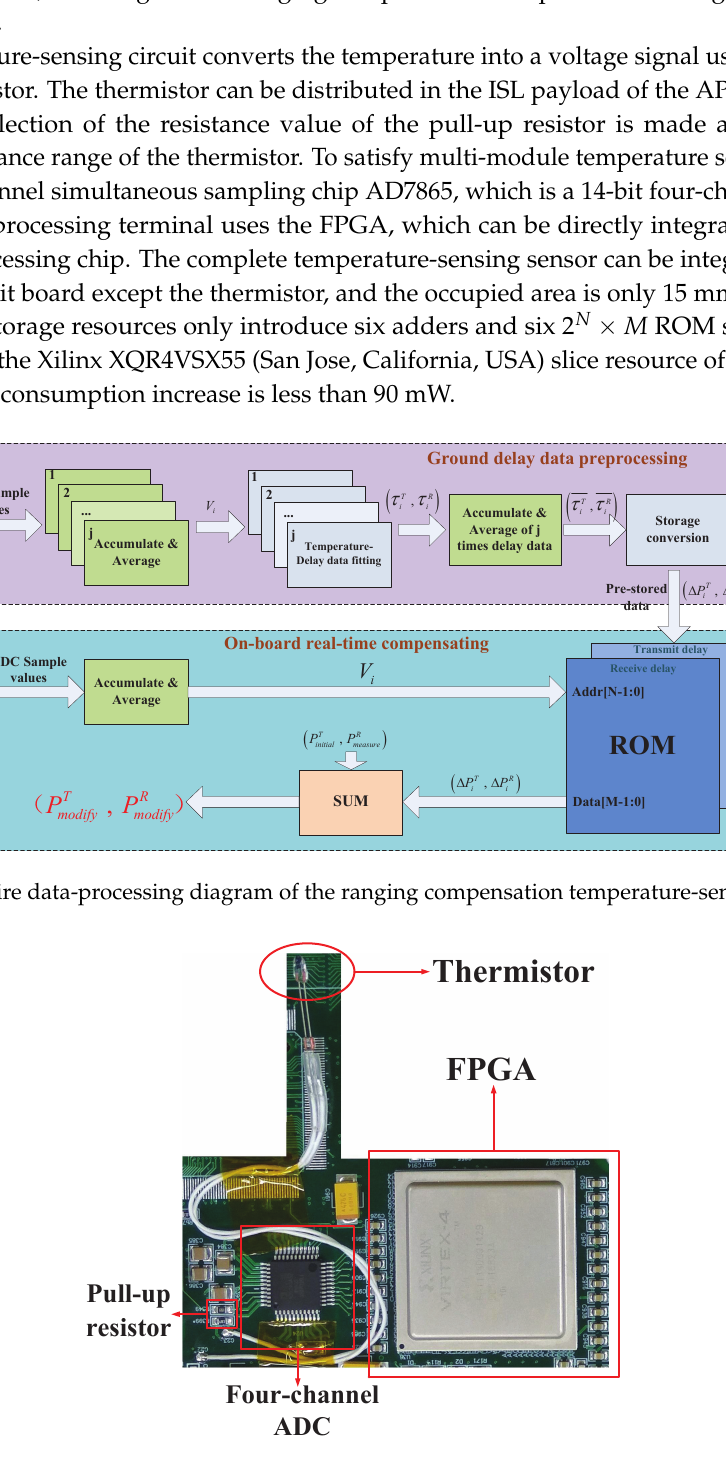
Figure 5. Design of the ranging compensation temperature-sensing sensor